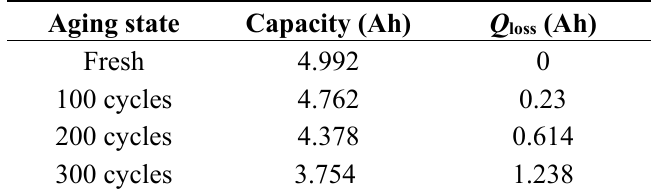
Table 2. Cell capacity and capacity loss at different aging states.